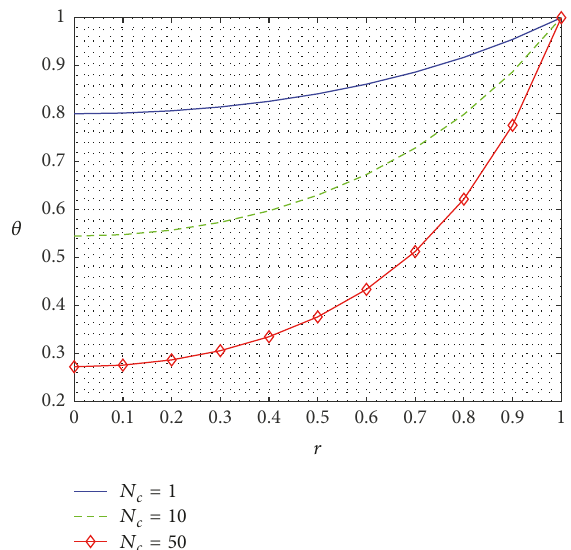
Figure 3: Plot of the temperature with 𝜃 𝑎 = 0.2 , 𝑟 ∗ = 1/1.75 , and N = 1 for 𝑇 = 1 and varied values of N 𝑟